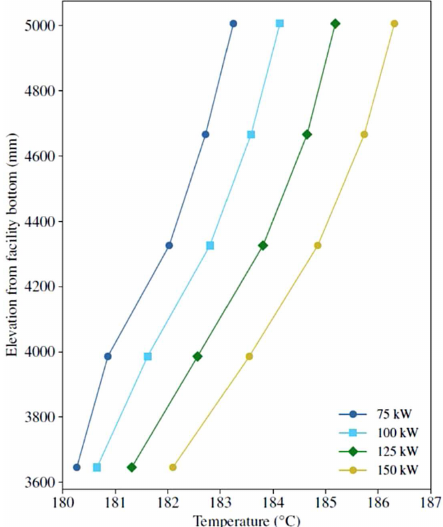
Fig. 5. Primary side steam generator axial temperature pro- files with different core power levels during the MS-SG02 experiment.